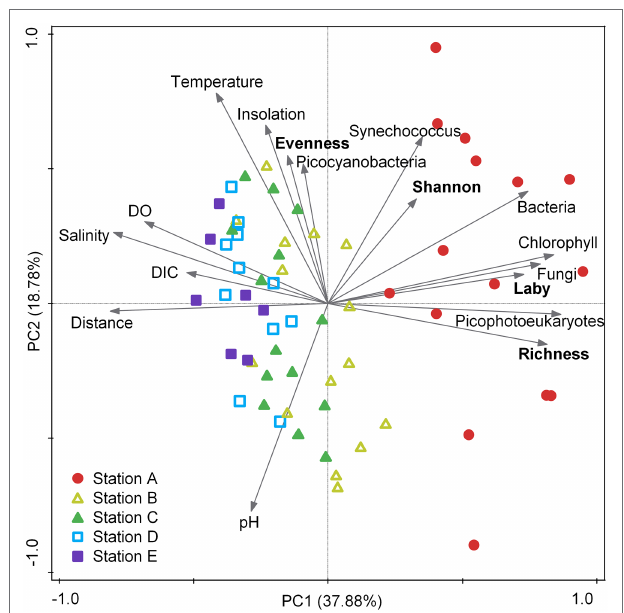
FIGURE 3 | Principal component analysis (PCA) ordination for the environmental gradients with the Labyrinthulomycete abundance (Laby) and diversity metrics (richness, evenness, and Shannon’s). Taxonomic labels indicate abundances of corresponding groups as measured using flow cytometry (bacteria, picocyanobacteria, Synechococcus , and picophotoeukaryotes) or qPCR (Labyrinthulomycetes and fungi). Temperature: seawater temperature; DO: dissolved oxygen saturation; DIC: dissolved inorganic carbon; chlorophyll: chlorophyll a ; Distance: distance from the shore; insolation: daily blue-sky insolation, which indicates the sampling date of the